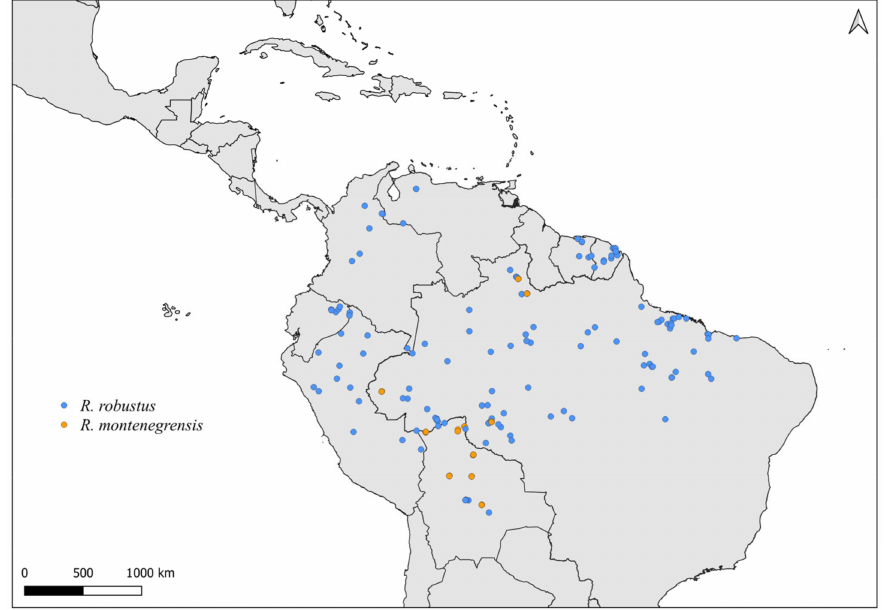
Figure 9. Distribution maps for R. robustus and R. montenegrensis .